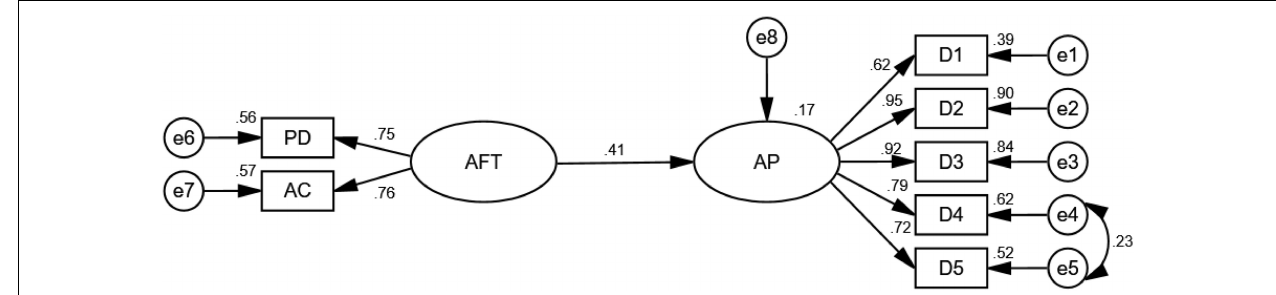
FIGURE 3 | A model of the relationship between academic frustration tolerance and academic performance.